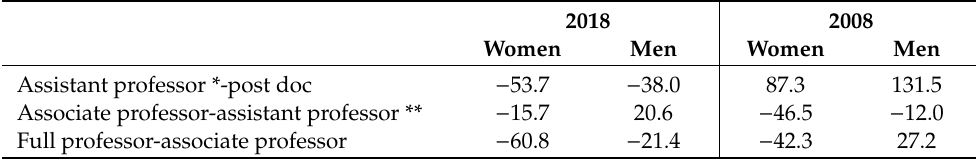
Table 1. Step by step % variation in the academic career by gender, Italy, 2008 and